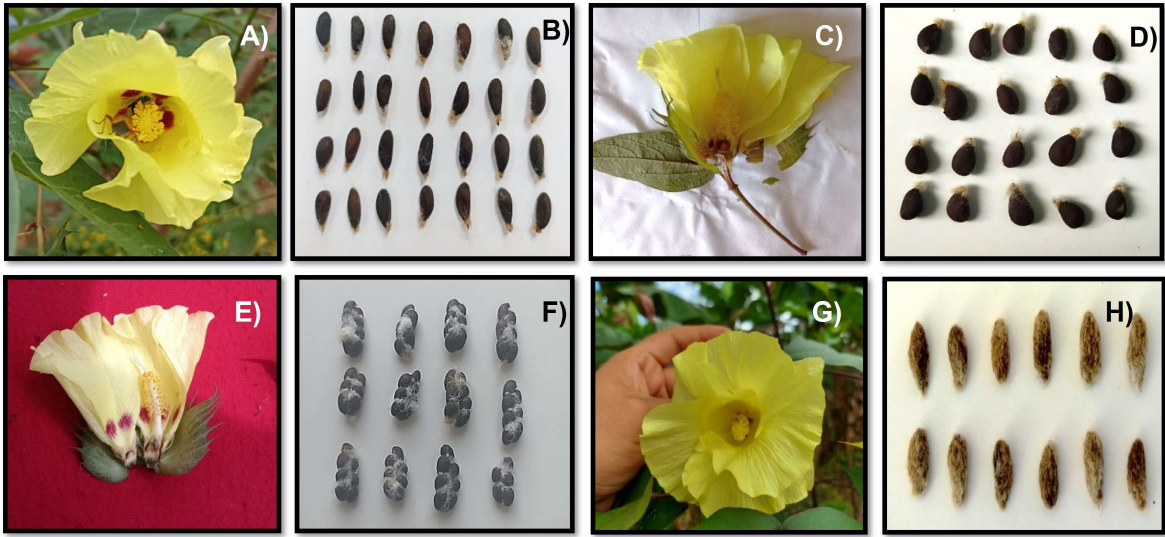
Figure 1. Details of the flowers ( A , C , E , G ) and seeds ( B , D , F , H ) of the species G. barbadense L. ( A – D ), G. hirsutum L. ( G , H ) and the variety G. barbadense L. var. brasiliensis ( E , F ), Cusco-Peru.